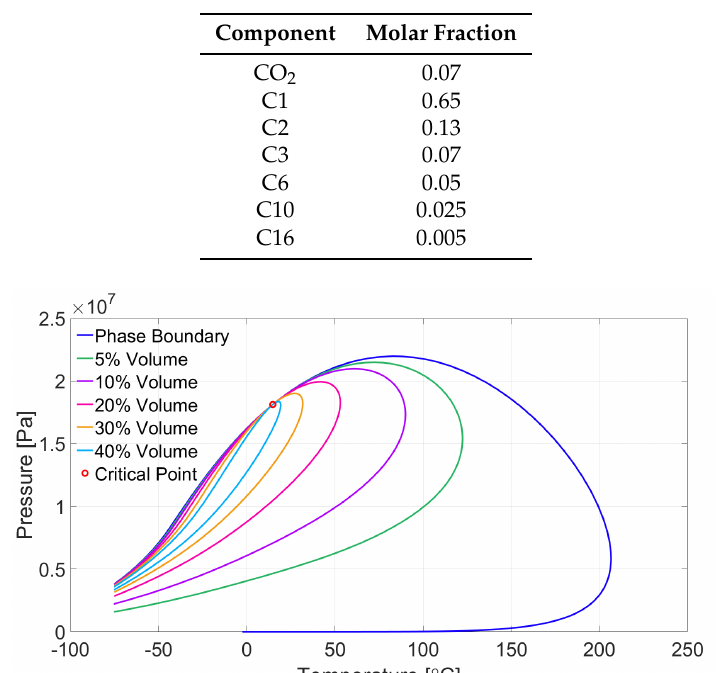
Figure 8. Fluid mixture phase envelope.